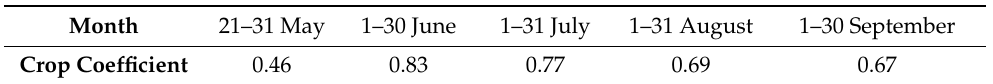
Table 1. Values of the crop coefficient for the Penman-Monteith formula for Jerusalem artichoke grown in the Kuyavia region